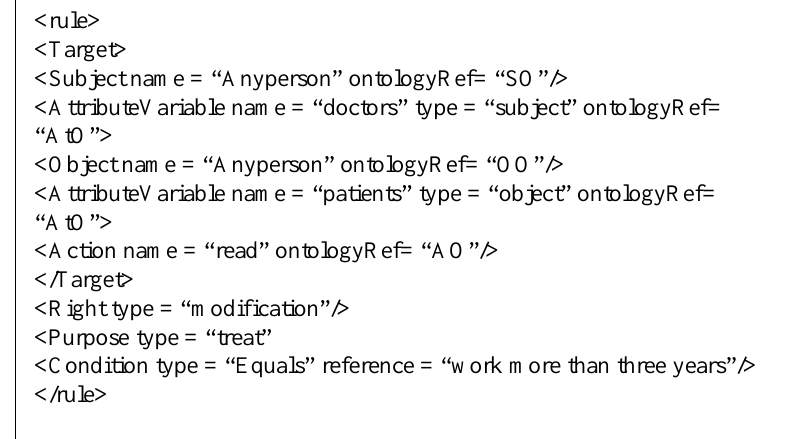
Figure 8. XML–based rule structure of